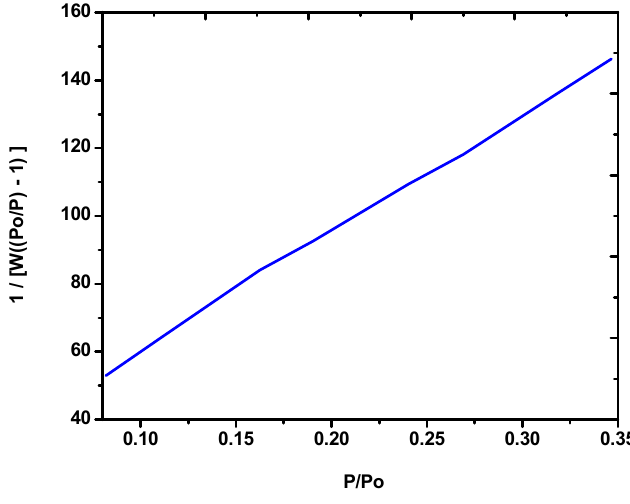
O @SiO nanoparticles. 2 4 2